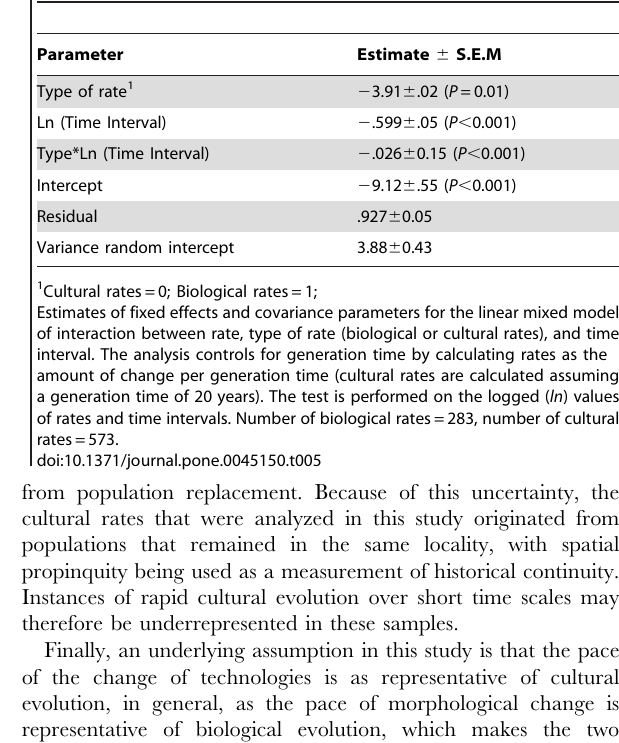
Table 5. Controlling for the effect of generation